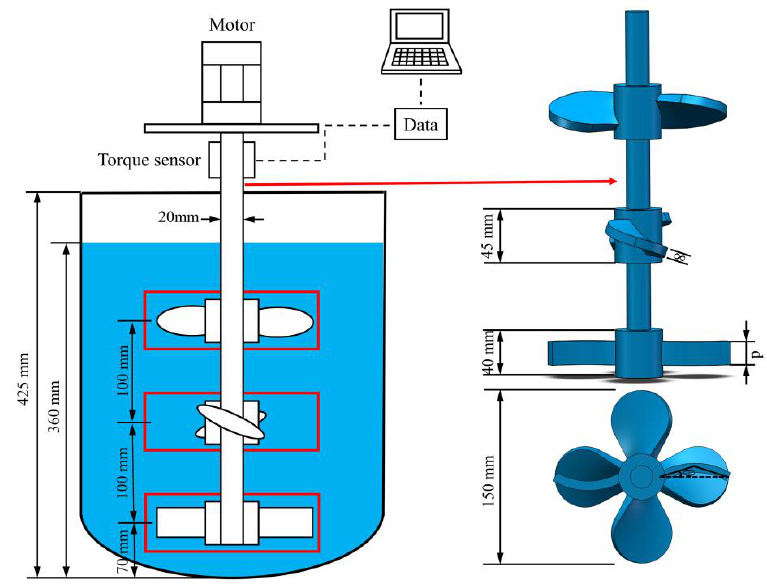
Figure 1. Schematic of the experimental device. The three-blade combined agitator (TBCA) is composed of two propeller blades of the same type and a curved blade. The blade width of the curved blade is d = 20 mm, the nominal diameter of the blade D Jc = 150 mm, and the inclination angle of the front and rear blades of the curved blade is θ = 30°. The propeller blades used in the experiment can be divided into helical propeller blades a and planar propeller blades b, according to the shape of the blades. The nominal diameters of the two propeller blades are D J =150 mm. Figure 2 shows the geometric details of the TBC-A type agitator, TBC-B type agitator and